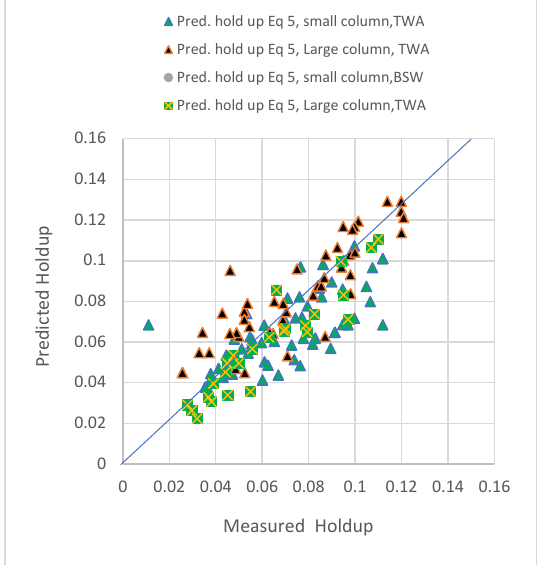
Figure 10. Comparison of the measured and predicted dispersed phase holdup values (from Equation (5)) obtained from the small and large columns, for all four distributors and two systems. For validating the new Equation (5), samples for some runs were drawn in a sepa- rate subplot, as seen in Figure 11. The trends measured and that predicted by Equation (5) were in good agreement.